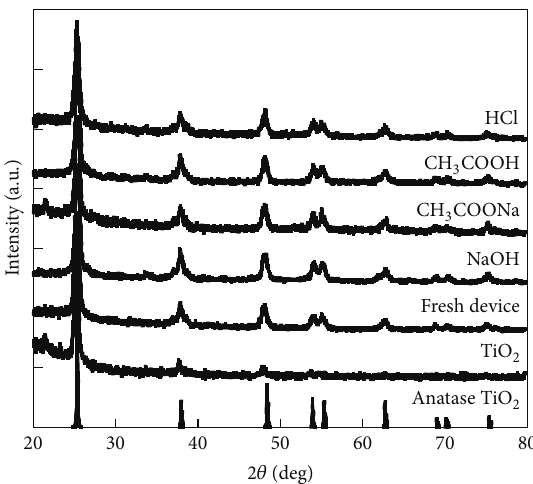
Figure 5: X-ray diffraction patterns of TiO 2 film that has undergone desorption by NaOH, CH 3 COONa, HCl, and CH 3 COOH solutions.